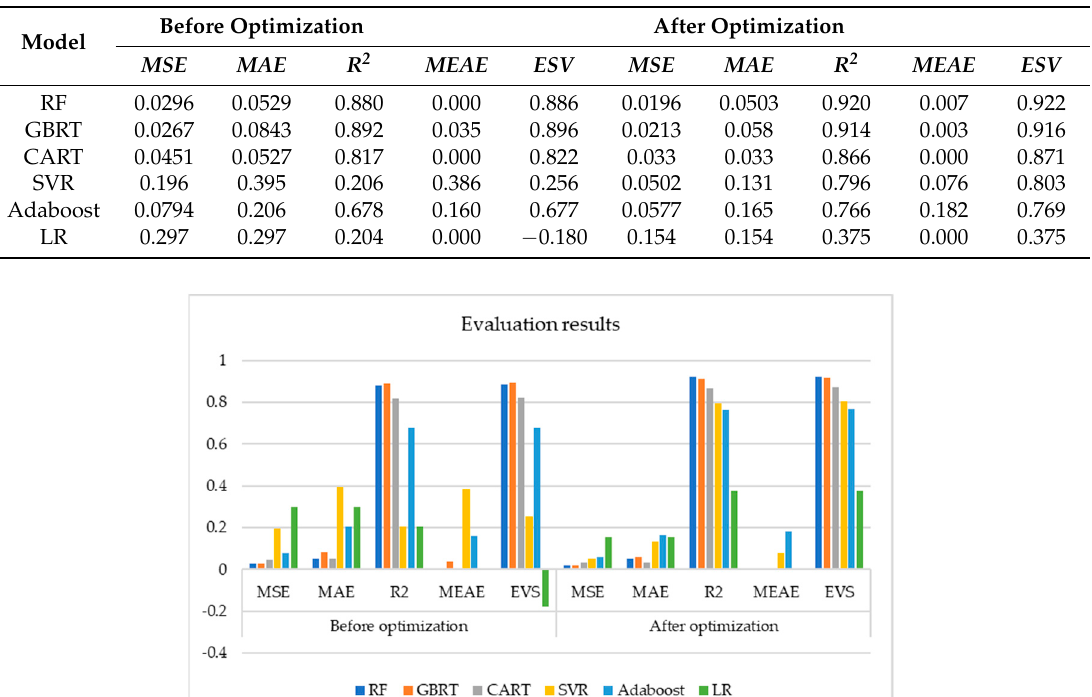
Table 3. Evaluation results of six models before and after optimization.